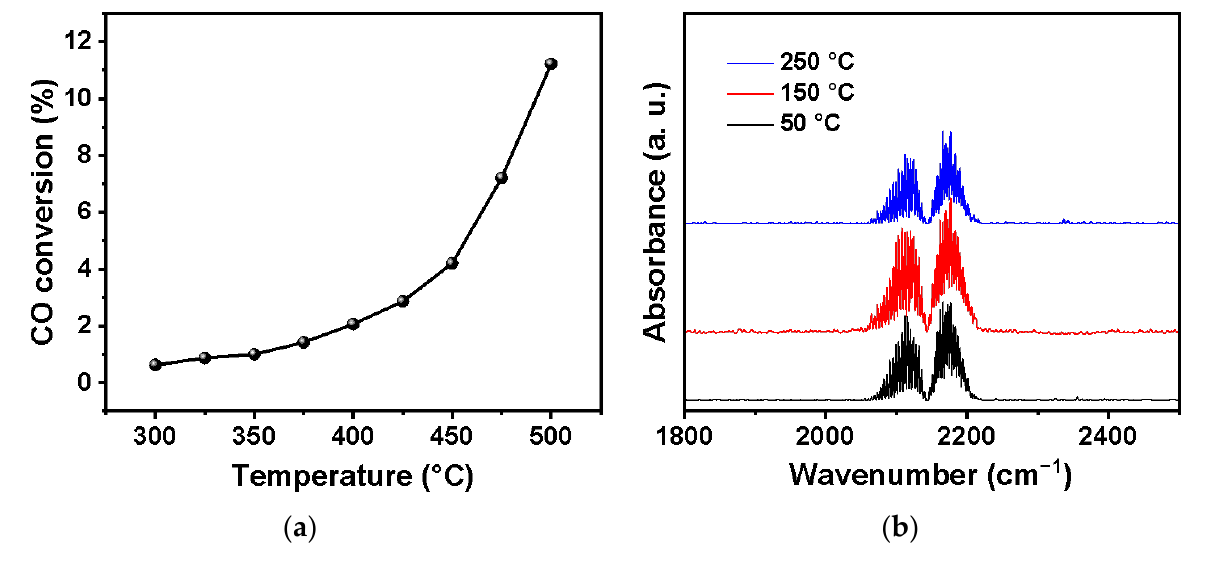
Figure 5. ( a ) CO conversion of YSZ powder with the gas flow of 0.5% CO, 10% O 2 , and balance N 2 . ( b ) In-situ DRIFTS spectra of YSZ-coated substrate at different temperatures with the same gas flow.